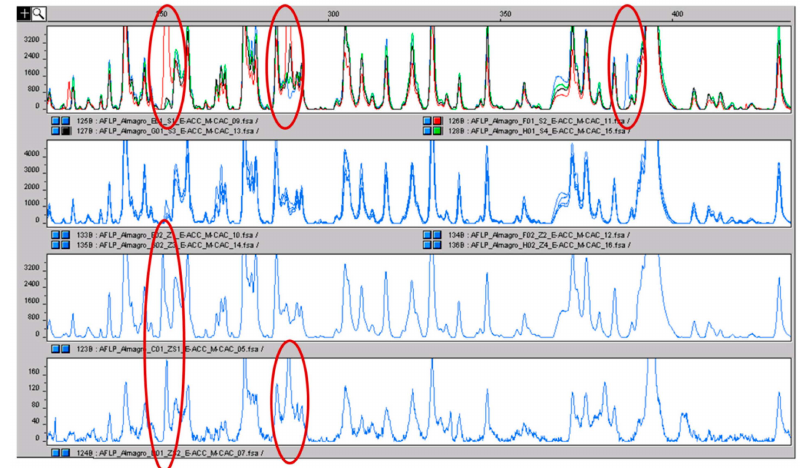
Figure 6. In the upper panel, the AFLP profiles of the four pools of stamens are shown in different colors. The polymorphic peaks are clear and evidenced with the red circle. The second panel shows the profiles of the four pools of stigmas coming from the same accessions from which the stamens were sampled: the color is equal because no inter-pool differences were present. In the last two panels, the profiles of two stigma-stamen mixtures are shown. The polymorphisms of the stamens, absent in stigmas, can be detected (red circles). The fact that the same polymorphisms were detected by repeating the analysis is a clear indication that they are true polymorphisms and not just false positives.